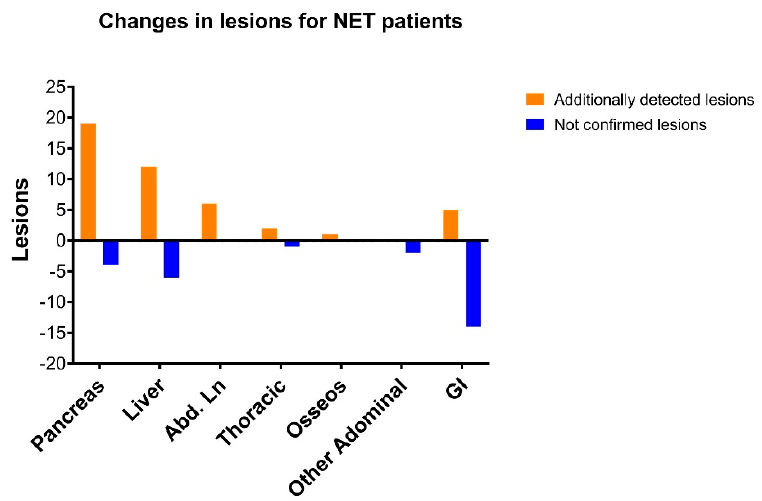
Figure 2. Differences in 68 Ga-DOTATOC-PET/CT-positive lesions in NET patients. Abbreviations: Abd. Ln: abdominal lymph node; GI: gastrointestinal. Abd. Ln: abdominal lymph node; GI: gastrointestinal.